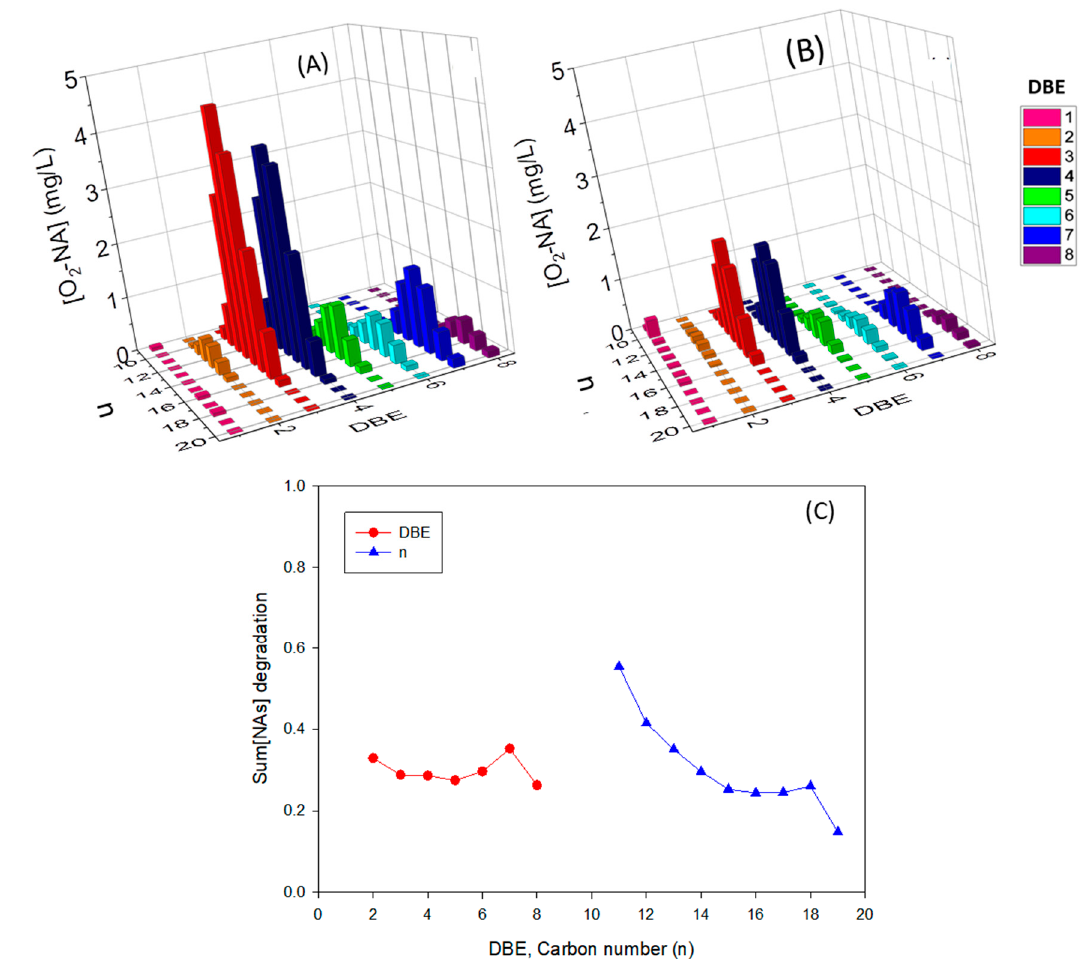
Figure 6. Profiles of O 2 -NA concentration versus carbon number (n) and double bond equivalent (DBE) values before and after wetland treatment ( A ) Day 0 (untreated), ( B ) Day 27 (wetland system), and ( C ) profile of the ratio of NA Σ DBEo / NA Σ DBEi and NA Σ no / NA Σ ni versus DBE values and carbon number, respectively, in the wetland treatment system. Figures A and B are adapted with permission from [36] Table 1. The abundance (%) of the NAFCs in untreated and wetland treated OSPW sample. Abundance NAFCs